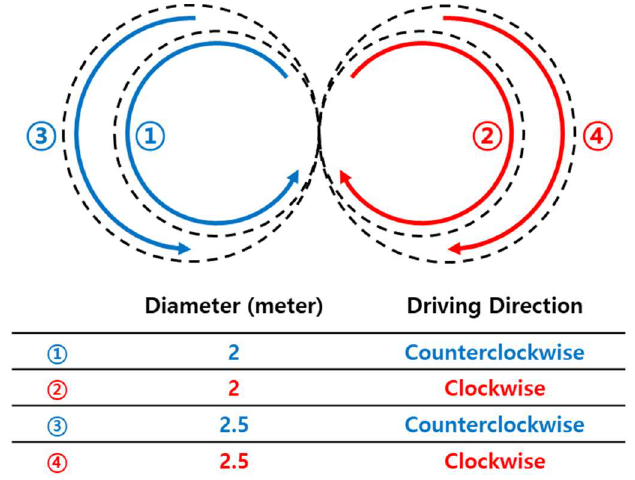
Figure 9. Numerical drift test scenarios.